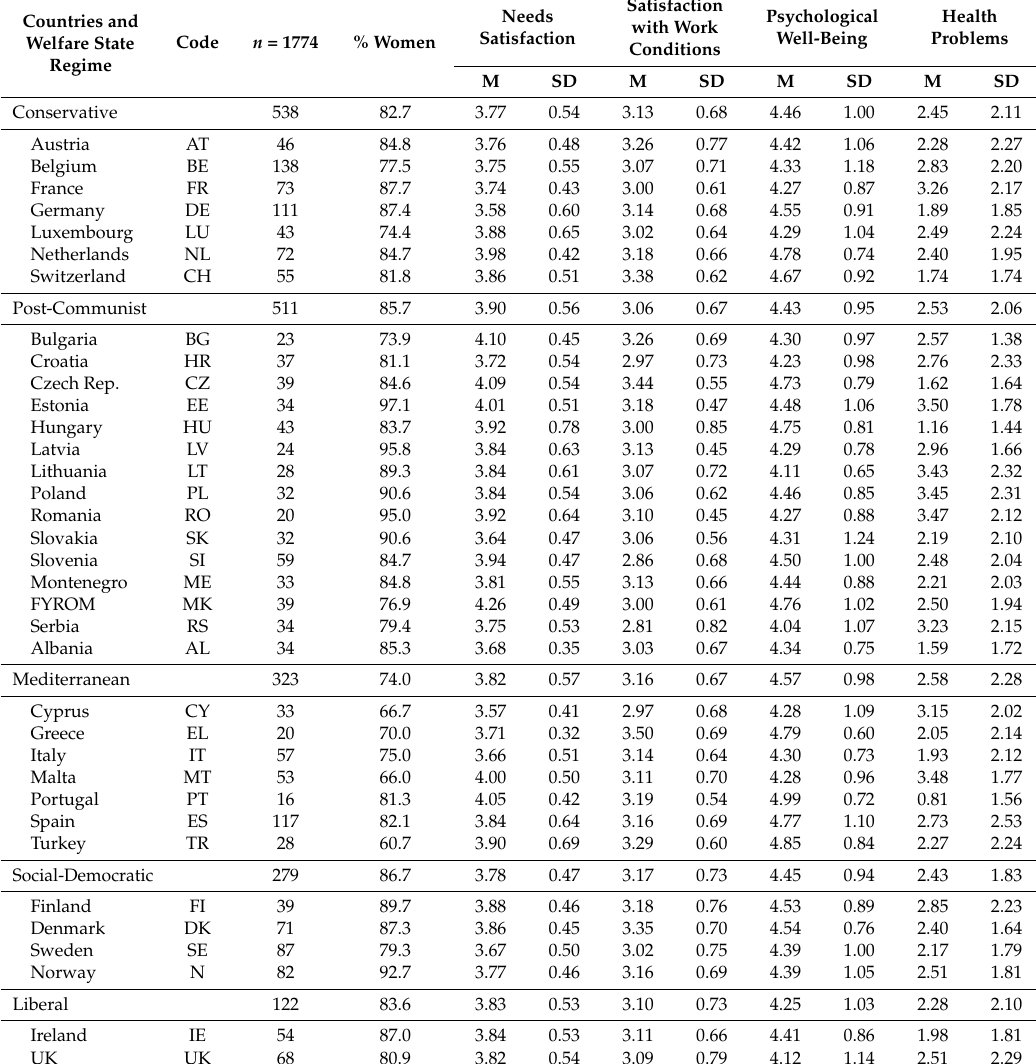
Table A1. Descriptive statistics of study variables and sample composition by country and by welfare state